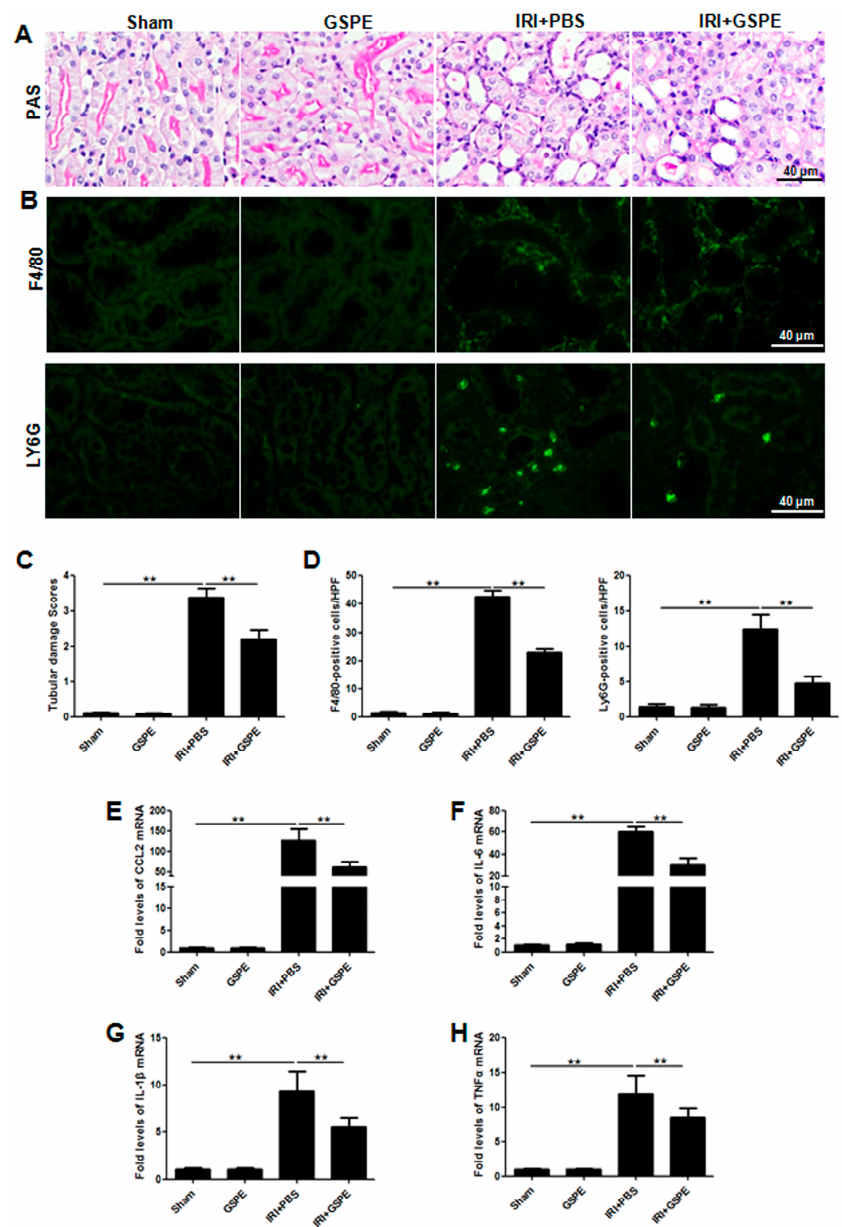
Figure 6. Administration of GSPE attenuates unilateral IR-induced chronic kidney injury and tubulointerstitial inflammation. ( A ) Morphological changes in kidney sections were examined by PAS staining; ( B ) Immunofluorescence staining of F4/80 and LY6G in the kidney; ( C ) Semi-quantitative analysis of PAS to assess tubular damage for all mice studied; ( D ) Semi-quantitative analysis of immunofluorescence staining of F4/80 and LY6G in the kidney, based on the number of positive cells in 10 random areas for all mice collected; ( E – H ) The expression of inflammatory cytokines CCL2 ( E ), IL-6 ( F ), IL-1 β ( G ) and TNF- α ( H ) was measured by real-time PCR. The data shown are mean ± SEM (** p < 0.01; n = 7 per group).